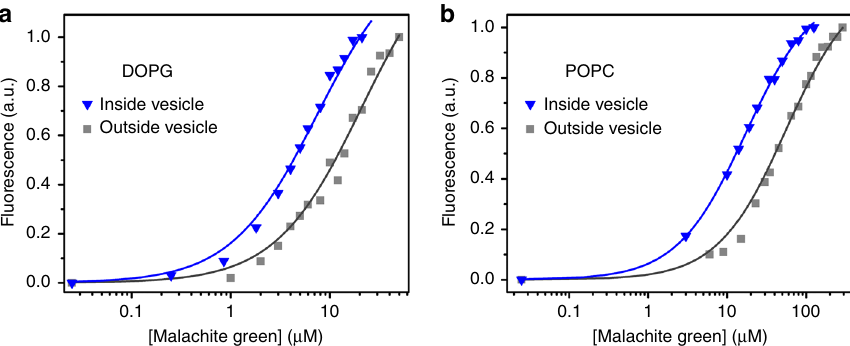
Fig. 3 MG aptamer af fi nity in phospholipid vesicles. Encapsulation also increases the binding af fi nity of MG aptamer to MG in the phospholipid vesicles of DOPG (blue triangles: K D = 7.1± 0.2 μ M; gray square: K D = 20 ± 1.7 μ M) ( a ) or POPC (blue triangles: K D = 18 ± 1.4 μ M; gray square: K D = 48 ± 8.6 μ M) ( b ). Values given are mean ± standard deviation